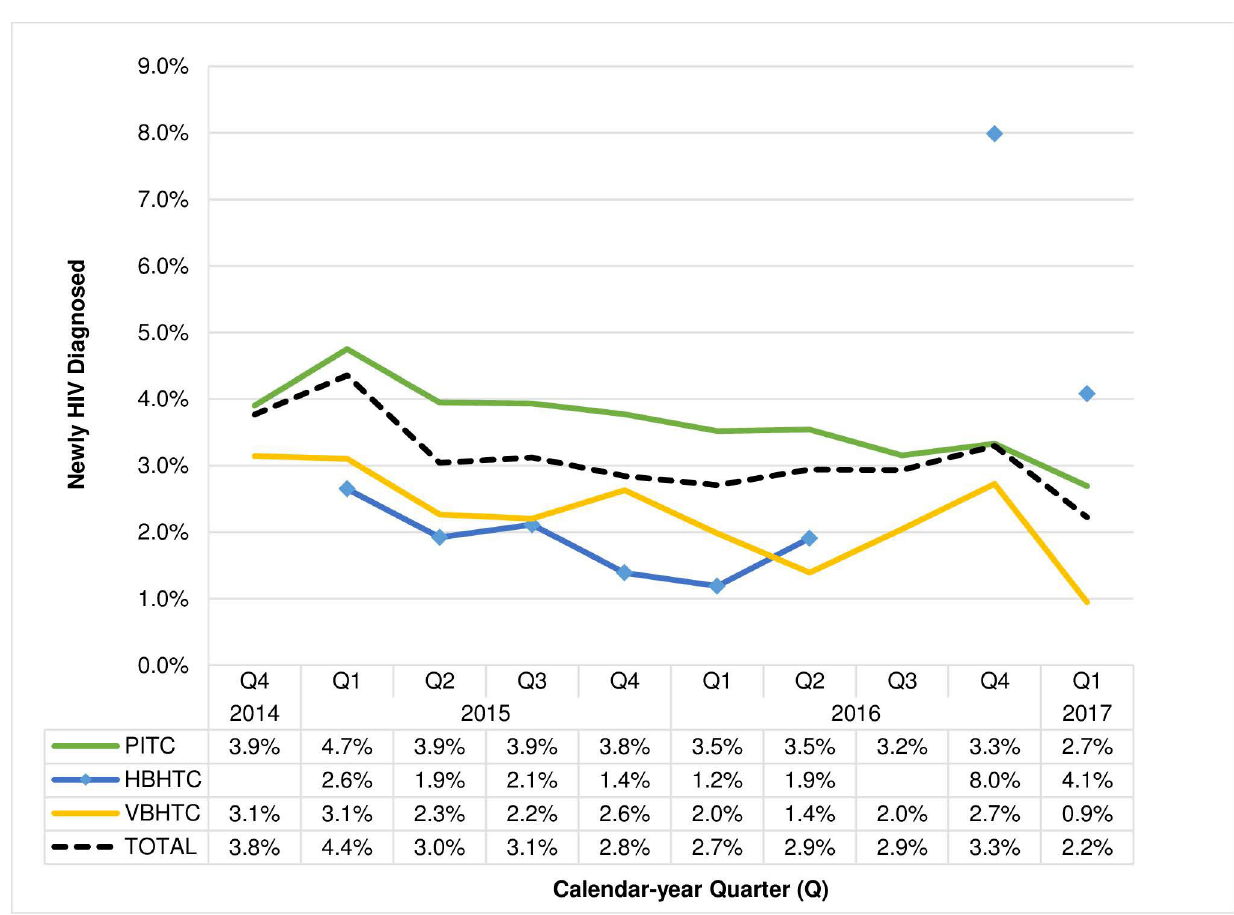
Fig 3. Proportion of clients newly HIV diagnosed by calendar-year quarter and HIV testing strategy, Bukoba Combination Prevention Evaluation, Bukoba Municipal Council, Tanzania, 2014-2017. a HIV, human immunodeficiency virus; PITC, provider initiated testing and counseling; HBHTC, home-based HIV testing and counseling; VBHTC, venue-based HIV testing and counseling. a All HIV-positive clients were screened to assess their new or prior diagnostic status. HIV-positive clients who reported having never previously tested HIV-positive were defined as newly HIV diagnosed. PITC began in Q4 2014 in seven of 11 health facilities and was implemented in all 11 facilities during Q1 2015 –Q1 2017. HBHTC teams visited all Bukoba Municipal Council (BMC) households on the mainland and offered HIV testing to encountered persons during Q1 2015 –Q2 2016. HBHTC was not conducted during Q3 2016. In Q4 2016, HBHTC teams visited all homes and offered HIV testing on two BMC islands. In Q1 2017, HBHTC was restricted to home clusters on the mainland that included partners and family members of persons diagnosed during VBHTC events. VBHTC was conducted on the mainland from Q4 2014 –Q1 2017 and on the islands in Q4 2016. VBHTC was conducted primarily in urban wards during Q4 2014 –Q3 2015, rural wards during Q4 2015 –Q1 2016, and urban wards Q2 2016 –Q1 2017. Proportion newly diagnosed was calculated by dividing counts of newly diagnosed clients by total HIV tests conducted for that quarter (Fig